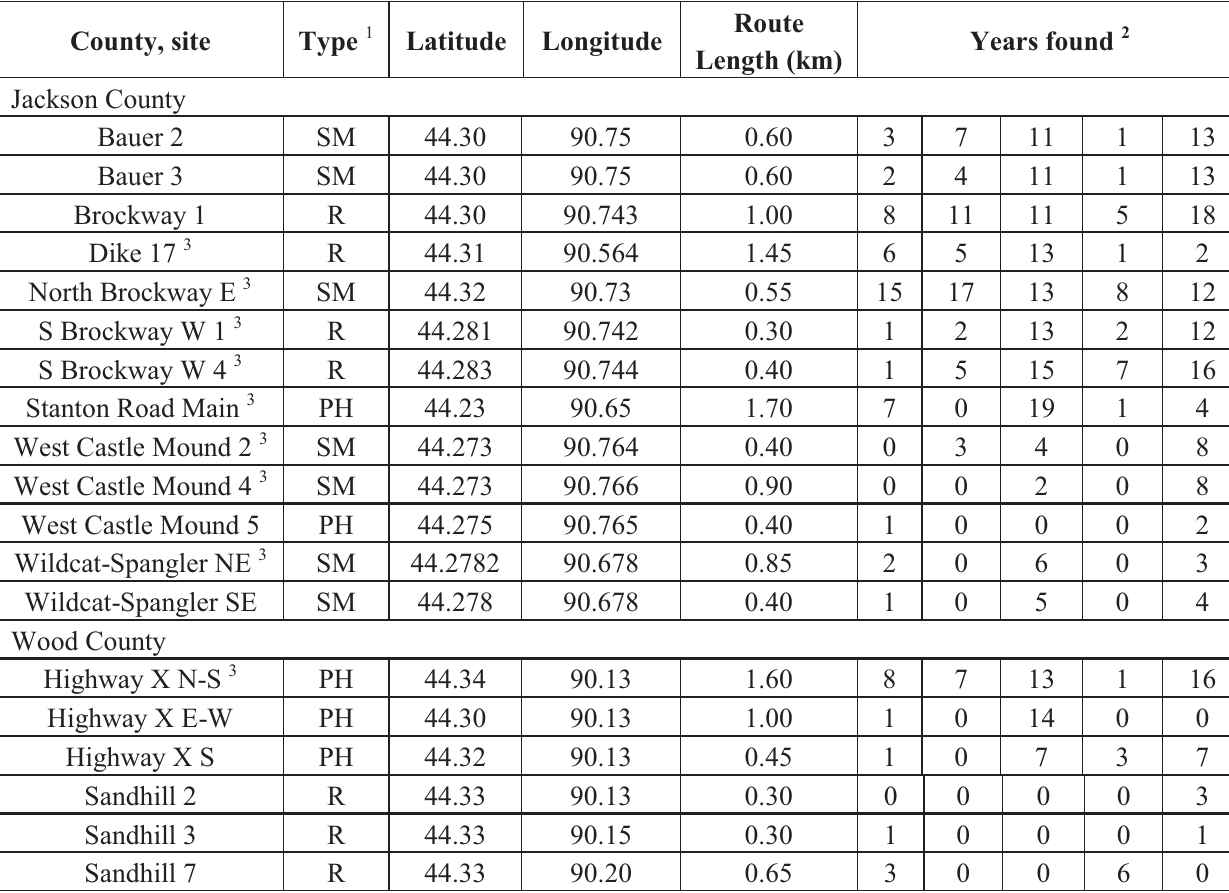
Table 2. Descriptive statistics on the long-term study sites surveyed each year 1994 – 2013. County,